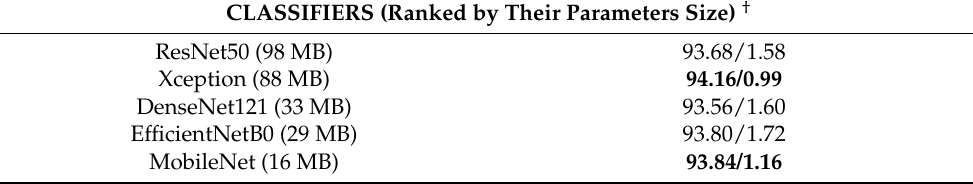
Table 1. 10-fold cross-validation results for various deep learning models. Bolded values of Mean accuracy/std.dev indicate they have the highest values in small-memory imprint or convergence- training performance